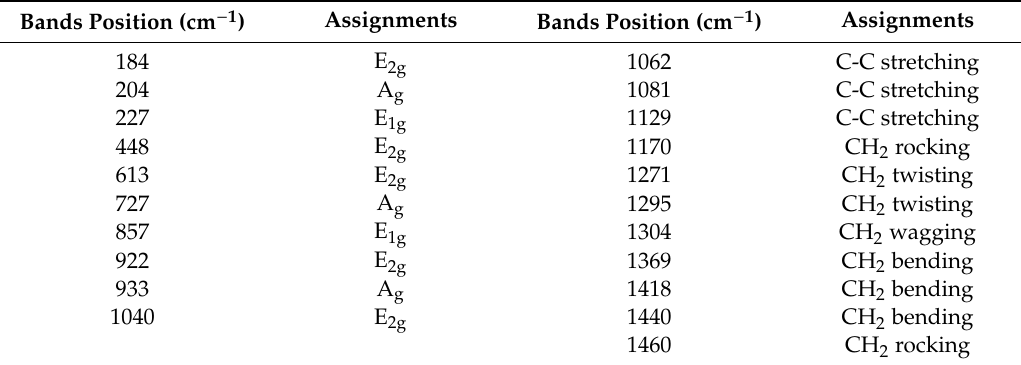
Table 1. Raman band assignments for Si 3 N 4 (left) and PE (right).